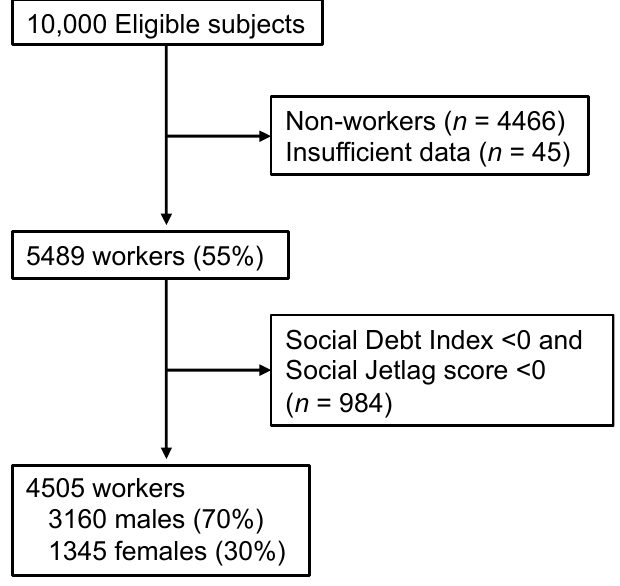
Figure 1. Study flowchart.